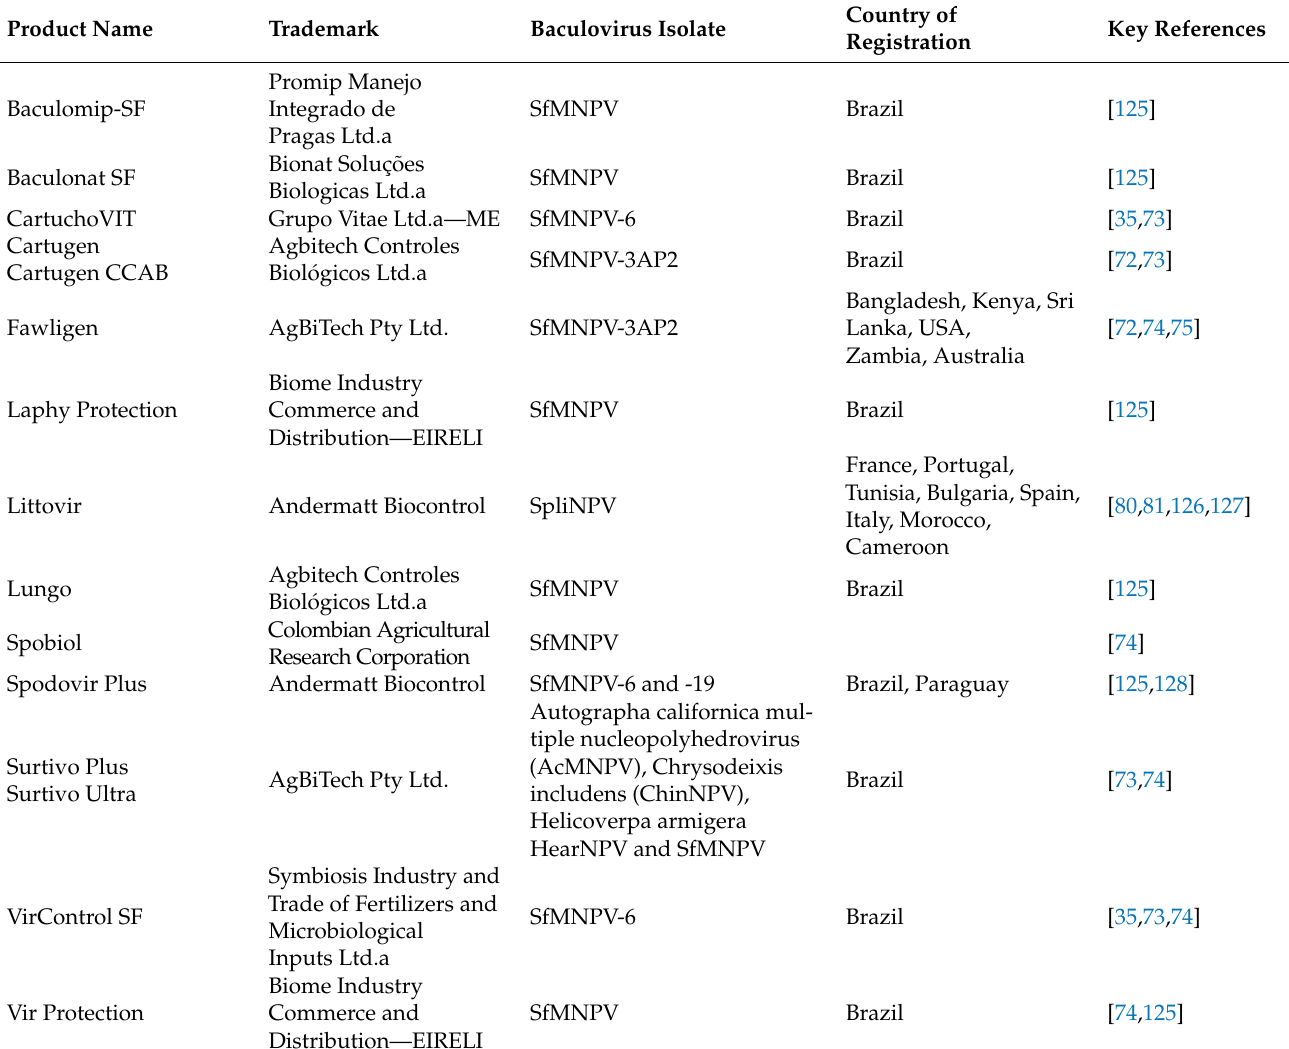
Table 4. Countries that have registered baculoviruses able to infect